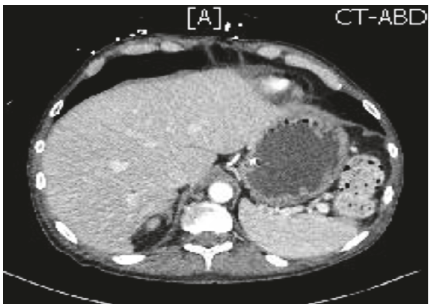
Figure 2: CT scan of the abdomen on the 5th day of admission showing resolution of air in the stomach wall and portal venous